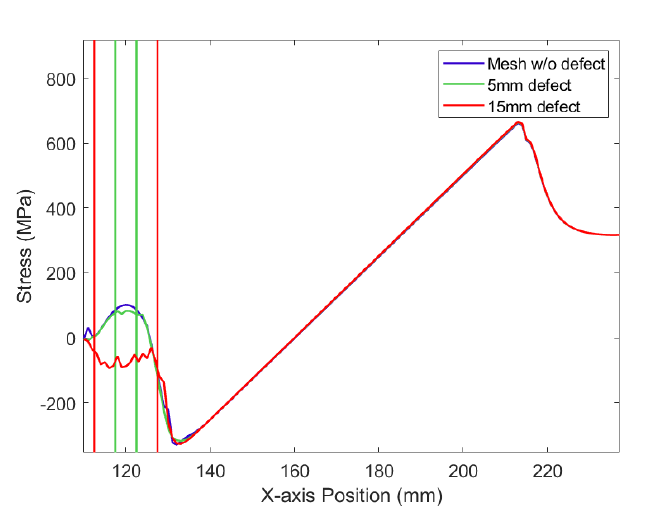
Figure 17. Stress profiles for the different